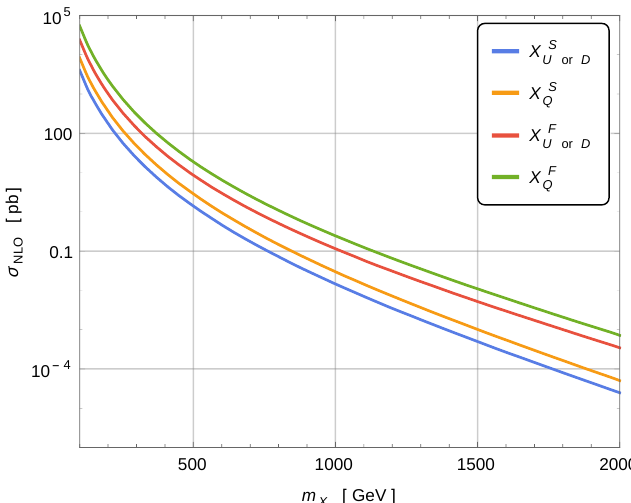
Figure 1. NLO cross sections for mediators of category I. The Hidden Valley group G is taken to be